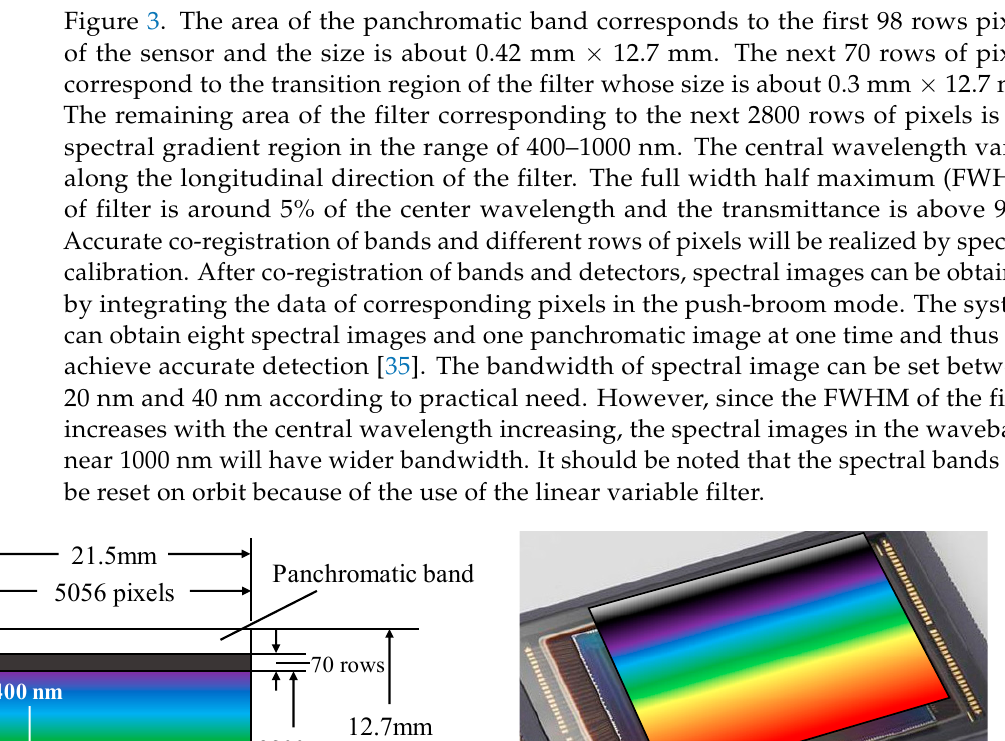
Figure 3. The area of the panchromatic band corresponds to the first 98 rows pixels of the sensor and the size is about 0.42 mm × 12.7 mm. The next 70 rows of pixels correspond to the transition region of the filter whose size is about 0.3 mm × 12.7 mm.